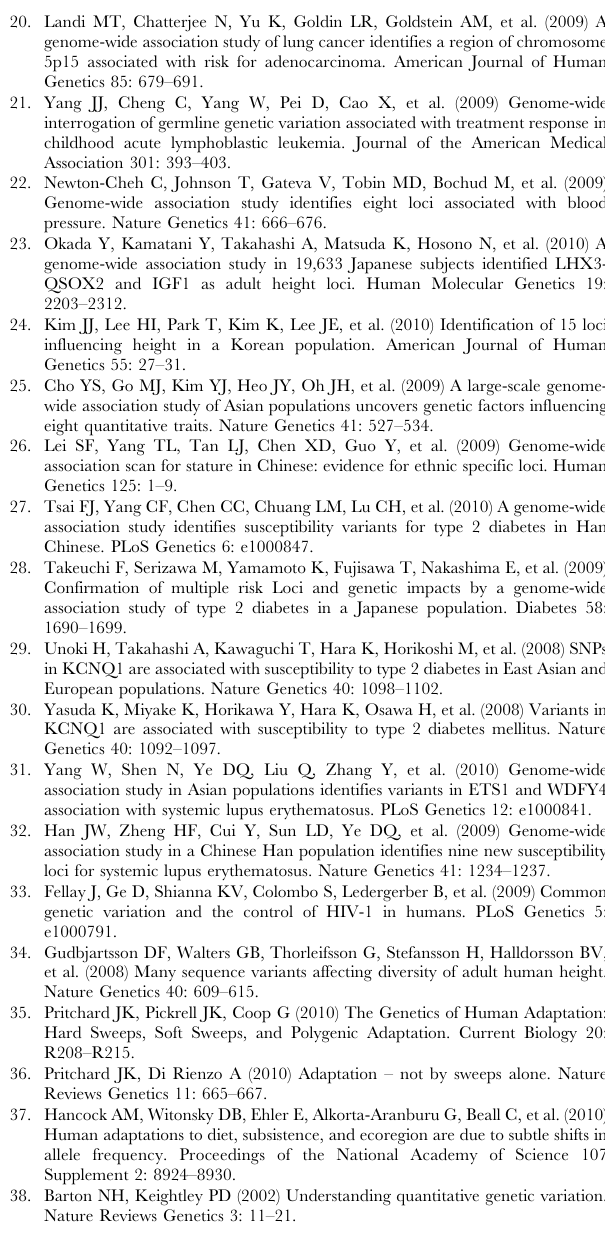
Table S1 List of 18 trait classes. Found at: doi:10.1371/journal.pgen.1001266.s010 (0.07 MB DOC) Text S1 Relationship between European MAF/LD score and measure P-value. Found at: doi:10.1371/journal.pgen.1001266.s011 (0.04 MB DOC) Text S2 Selection on GWAS SNPs and